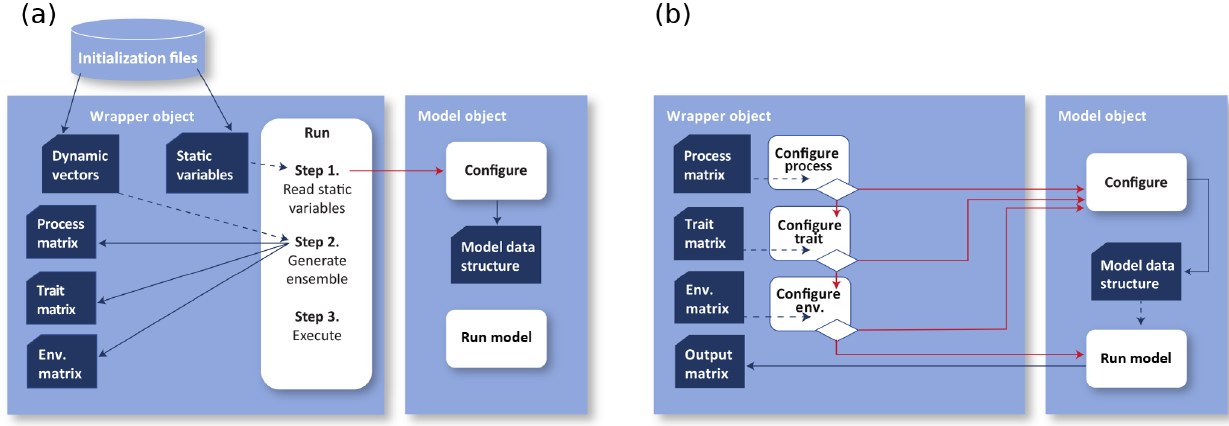
Figure 2. Schematic representing the basic software structure and execution process of MAAT. Panel (a) represents the operation of the first two steps of a MAAT execution: (1) reading user input data from initialization files and (2) generating ensemble matrices from dynamic variables. Panel (b) represents a single iteration of the “execution cascade”, which forms the third step of a MAAT execution. “Proto” objects (light blue boxes) contain data structures (dark blue shapes) and functions (white rectangles). Blue arrows represent the transfer of data via a read (dashed) or write (solid), and red arrows represent a function call. During the execution of the execution cascade, each execution function is associated with a particular variable type (process representation, parameter, environment), reads a line of the variable type matrix, and calls the model object configure function with the line from the matrix as an argument. The configure function writes the variable values to the model object data structure, then the function calls the next function in the execution cascade. The final function in the cascade is the model run function, which runs the model and writes output to the output data structure in the wrapper